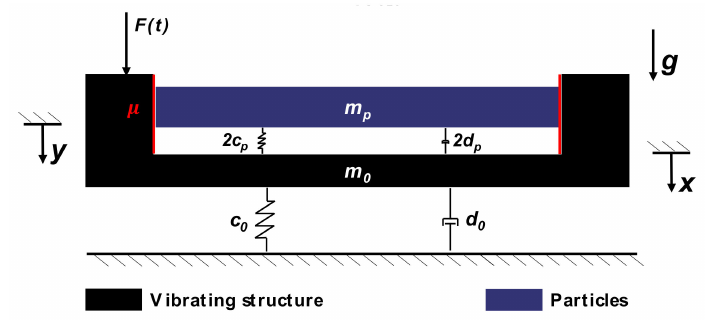
Figure 16. Mechanical model for laser beam melted particle